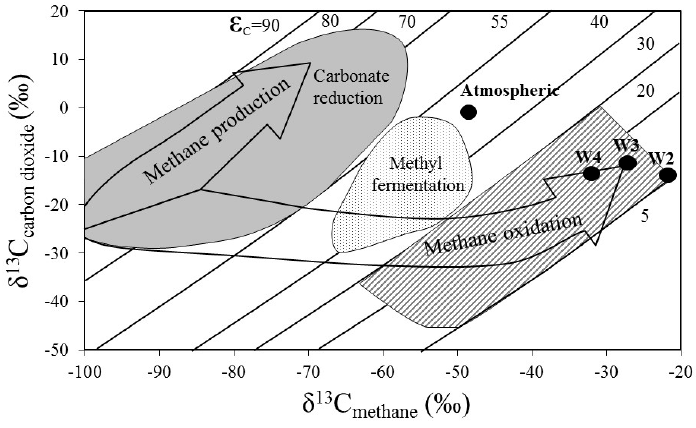
Figure 7. Methane oxidation and production pathway in the Wieliczka Formation sediments through stable δ 13 C methane versus δ 13 C carbon dioxide isotopes (adapted from Whiticar [45]).